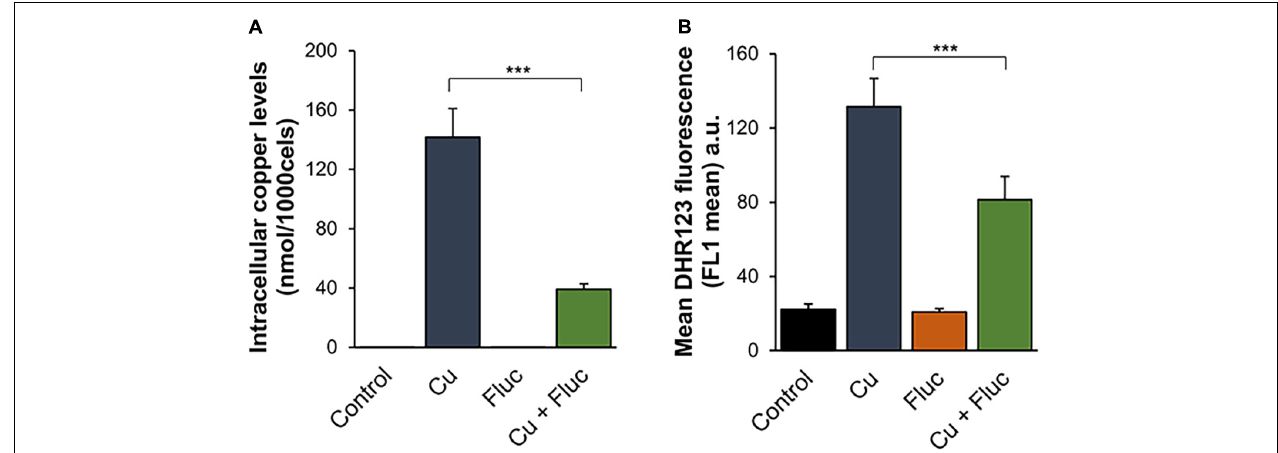
FIGURE 2 | Differences in copper accumulation do not explain the synergistic effect between copper and fluconazole. (A) The copper content of Candida glabrata cells left untreated (Control) or treated with 625 µ M CuSO 4 (Cu), 32 µ g/mL fluconazole (Fluc), or both (Cu + Fluc) for 24 h was determined by ICP-AES. (B) ROS detection in Candida glabrata cells left untreated (Control) or treated 625 µ M CuSO 4 (Cu), 32 µ g/mL fluconazole (Fluc), or both (Cu + Fluc) for 24 h, was performed by flow cytometry using DHR123. Values are the mean of five independent biological replicates with 100,000 cells counted per each condition. Significance of differences was calculated using the Student’s T -test (*** p -value <